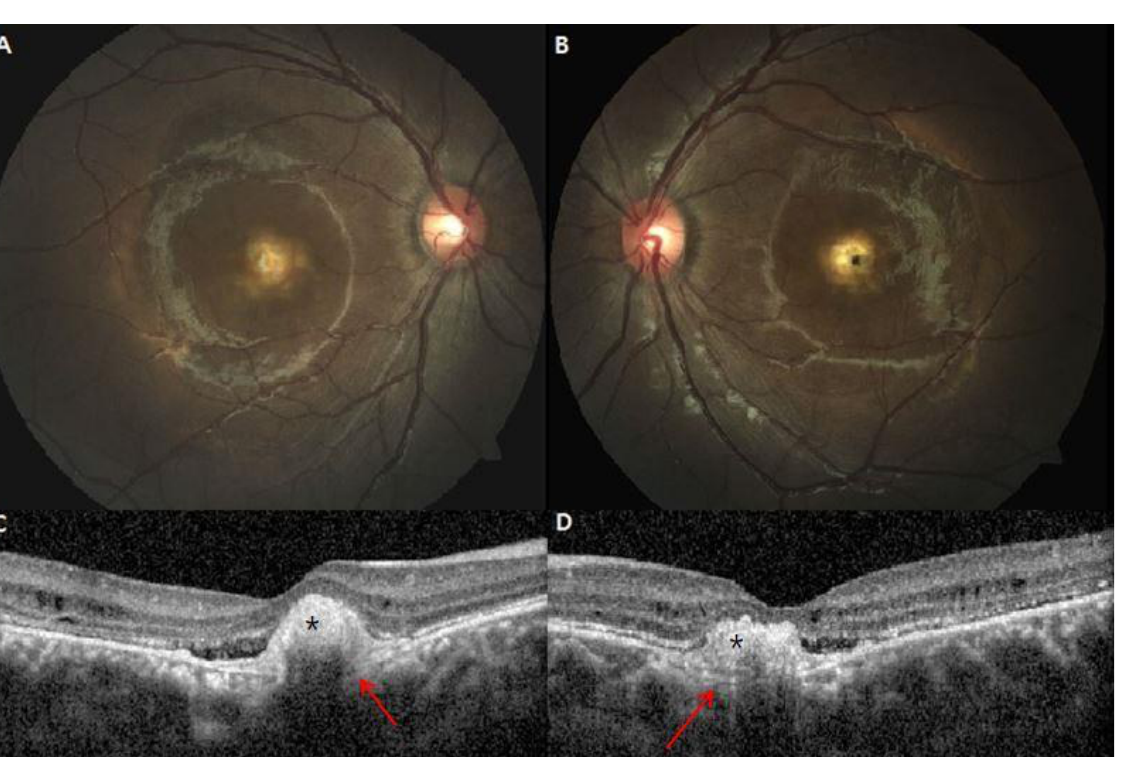
Table 2. Spectral-domain optical coherence tomography parameters of 20 eyes with autosomal re- cessive bestrophinopathy at initial and final